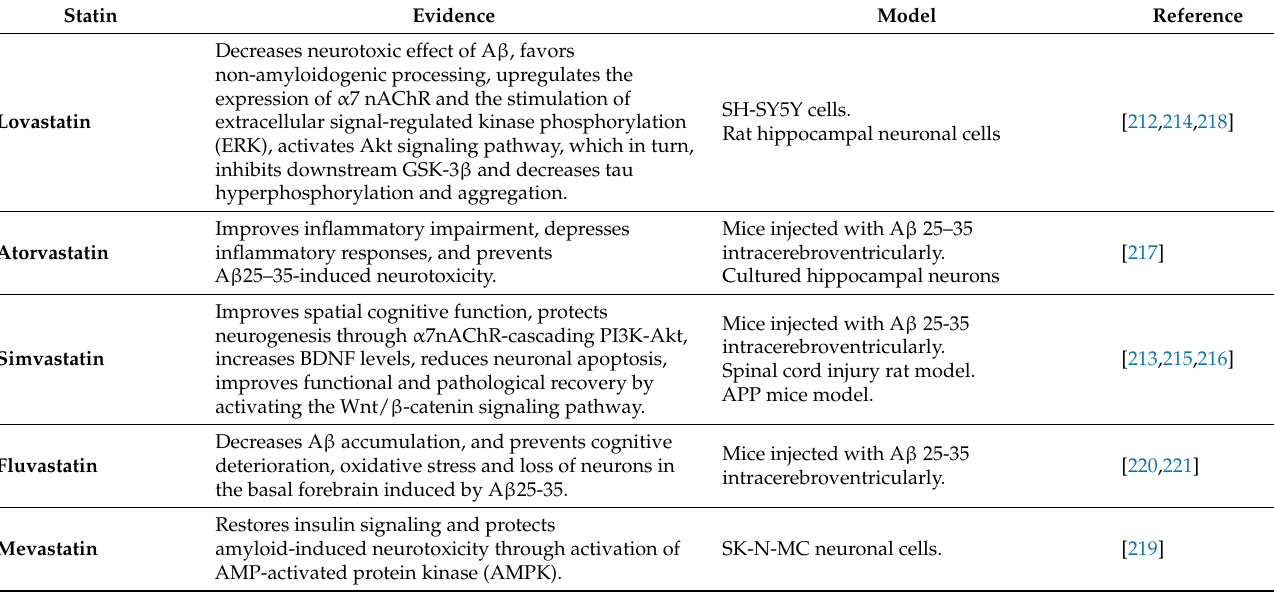
Table 1. Potential use of statins for the treatment of